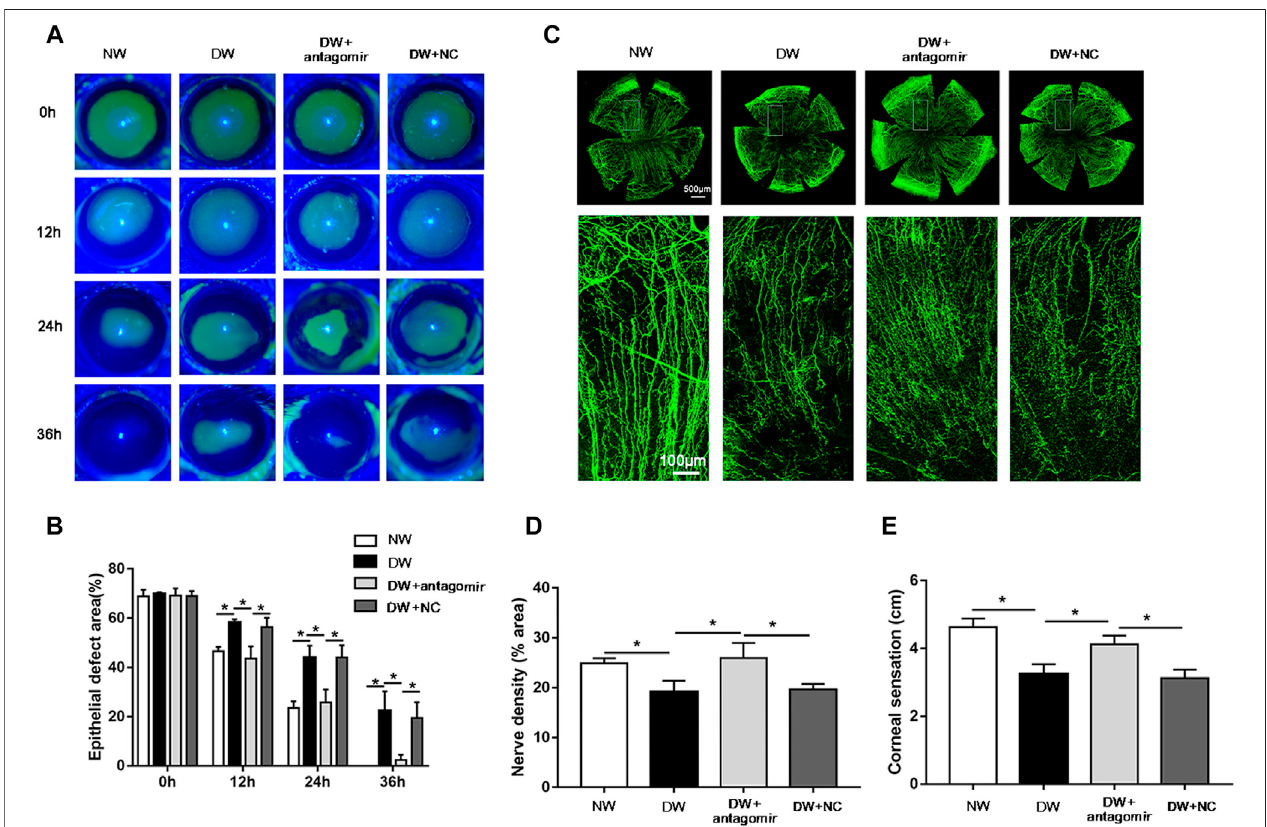
FIGURE 5 | Inhibition of miR-223-5p ameliorated corneal epithelial wound repair and nerve regeneration in diabetic mice. (A,B) The fl uorescence staining assay exhibited the corneal epithelial defect of normal mice (NW group), diabetic mice (DW group), diabetic mice subconjunctivally injected with miR-223-5p antagomir (DW + antagomirgroup),orantagomirNC(DW+NCgroup)at0,12,24,and36 hpost-injury. (C,D) Cornealwhole-mountstainingof β -tubulinIIIrevealingthecornealnervesof the above four groups on day 5 post-wounding. (E) The corneal sensation measurement was performed on day 5 post-wounding in these four groups. (B,D,E) Data were analyzed by one-way ANOVA. If signi fi cant, multiple comparations were then performed. * p -value of <